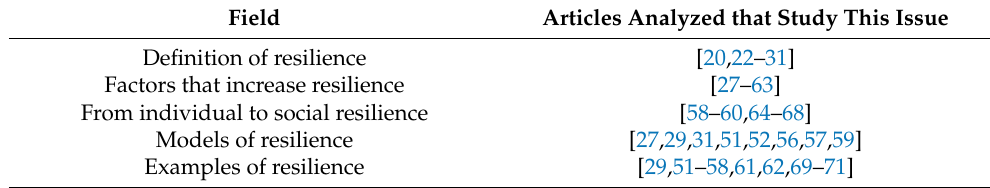
Table 1. Summary of main aspects of resilience analyzed in these articles referred.